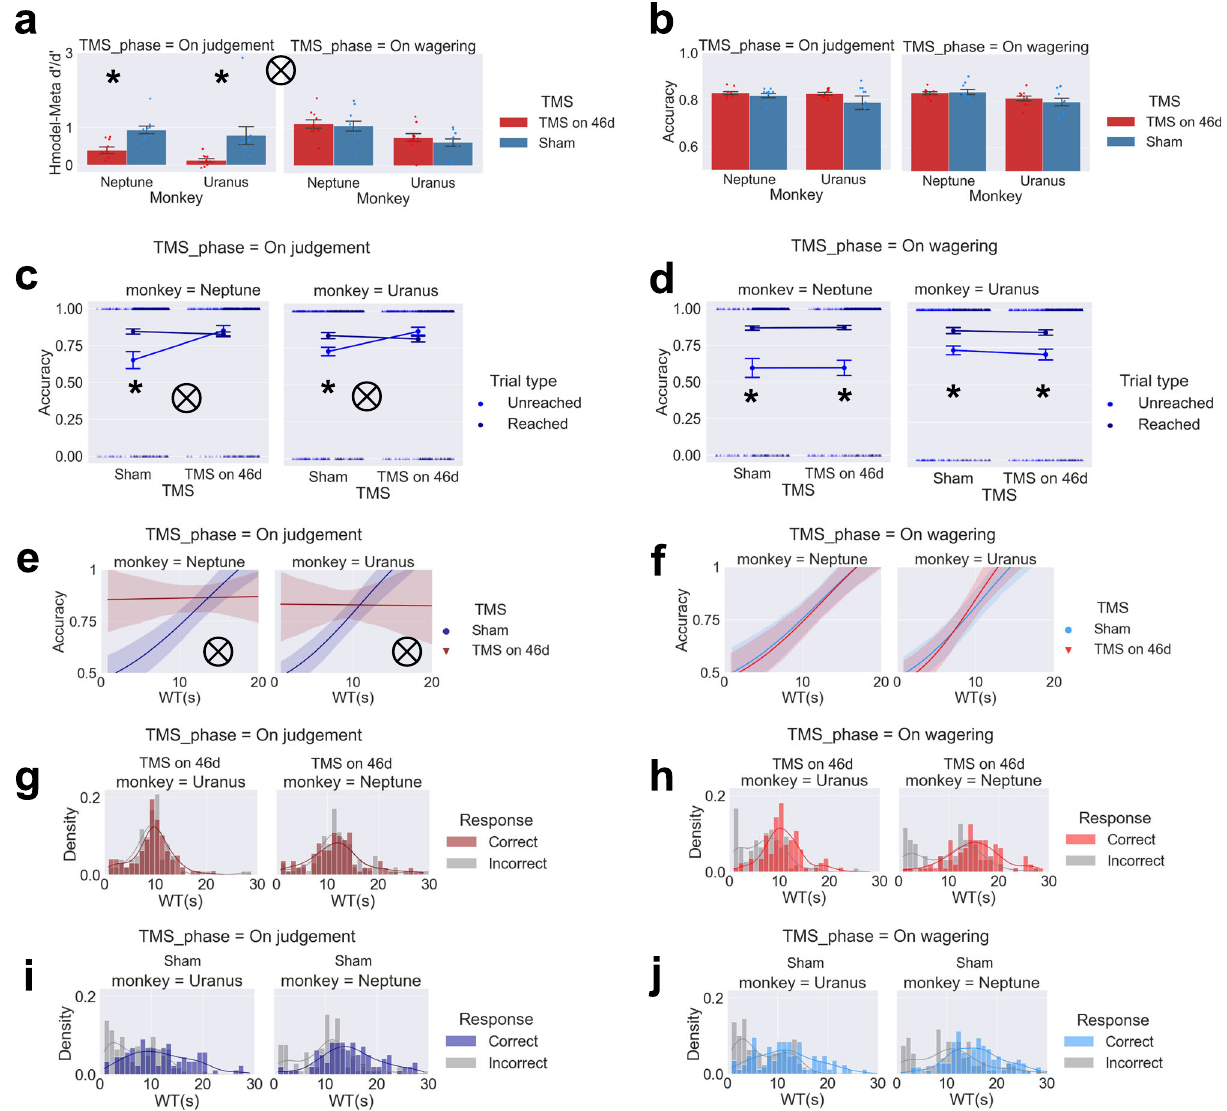
Fig. 2 TMS during the on-judgement phase disrupts metacognition and the response outcome tracking ability of wagered time (WT). The monkeys demonstrated an impairment in metacognitive ef fi ciency in the TMS-46d condition during the on-judgement phase but not during the on-wagering phase ( a ). TMS of BA46d does not affect task accuracy ( b ). Difference in accuracy between unreached trials (low con fi dence) and reached trials (high con fi dence) in the on-judgement phase and the on-wagering phase ( c , d , respectively). The trendlines are fi tted to accuracy by logistic regression with WT as a factor for the TMS-sham and TMS-46d conditions separately. WT reliably tracks response outcomes in the TMS-sham condition but not in the TMS- 46d condition during the on-judgement phase. WT tracks response outcomes in both the TMS-sham and TMS-46d conditions during the TMS on- wagering phase ( e , f ). Distributional differences between correct and incorrect WT. The largest effects were observed in the TMS-sham condition, in which the BA46d was not perturbed ( g – j ). The WT bin size was set to 1 s; coloured lines indicate kernel density estimation. Error bars indicate ± one standard error; * indicates p < 0.05. ⊗ indicates a signi fi cant interaction effect ( p < 0.05) of WT and TMS (TMS-46d/sham). Shaded areas indicate bootstrap- estimated 95% con fi dence intervals for the regression